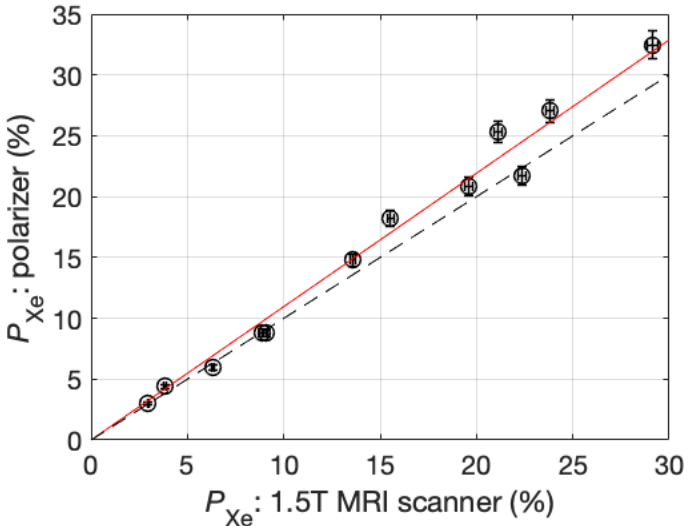
= ). P pol Xe Xe = P sc , Xe Xe